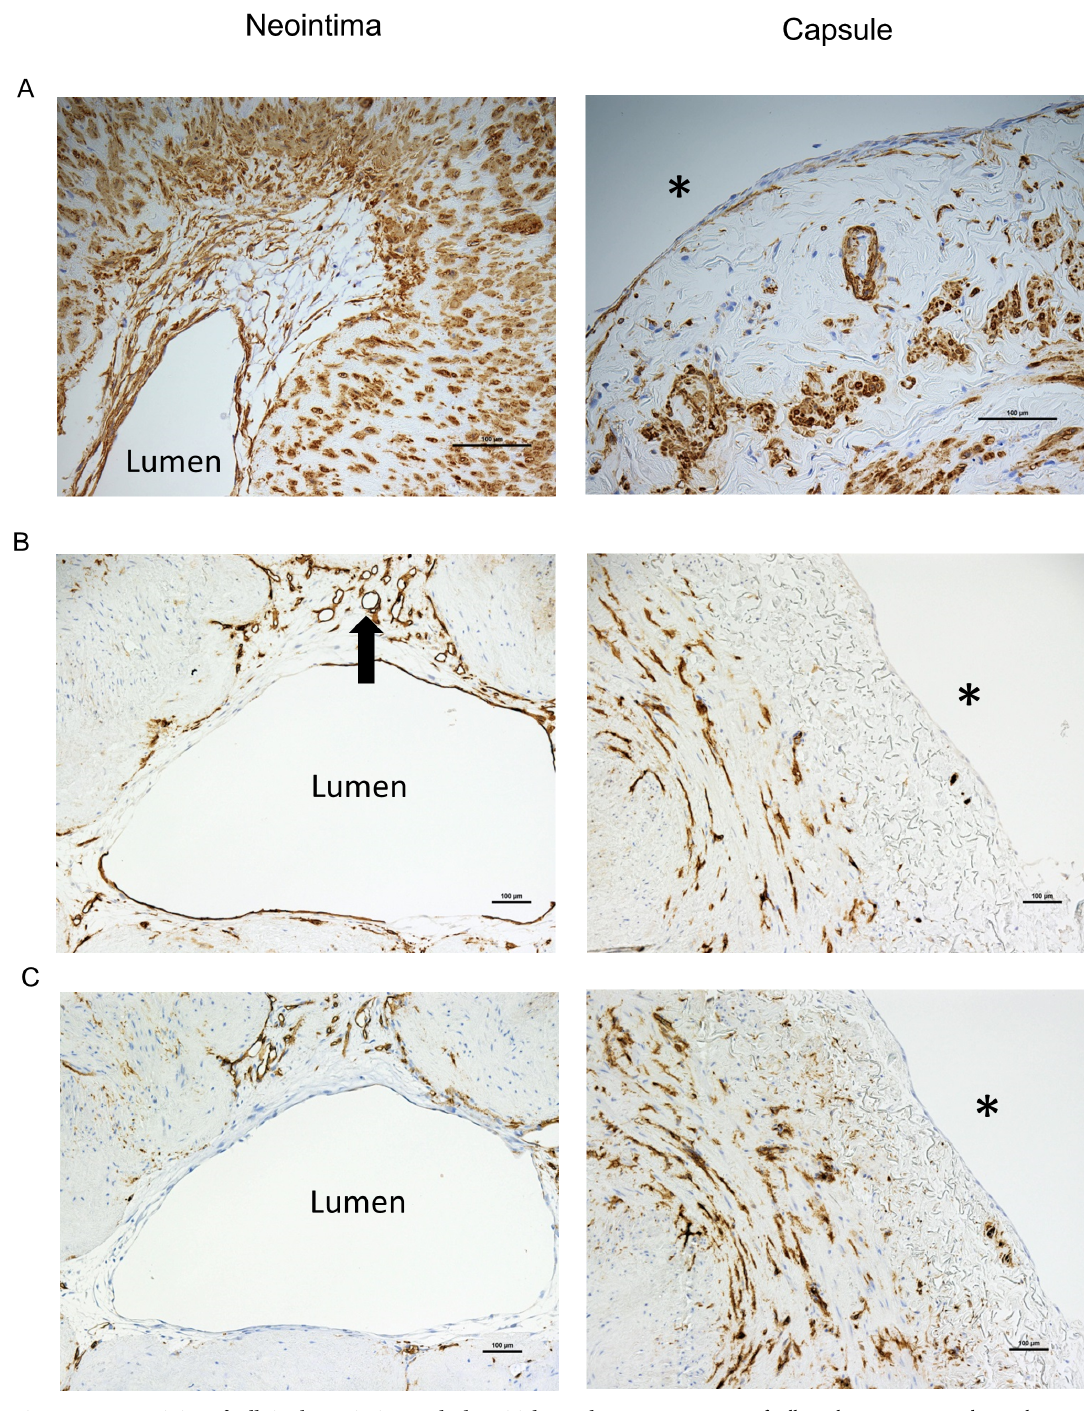
Fig 5. Immunostaining of cells in the neointima and adventitial capsule. Immunostaining of cells in the neointima and capsule surrounding the adventitia (left and right panels, respectively, for (A) smooth muscle alpha actin, (B) CD31 (arrow indicates an endothelialized neovessel), and (C) CD34. (cid:3) indicates the adventitial surface. Scale bars indicate 100 μm.